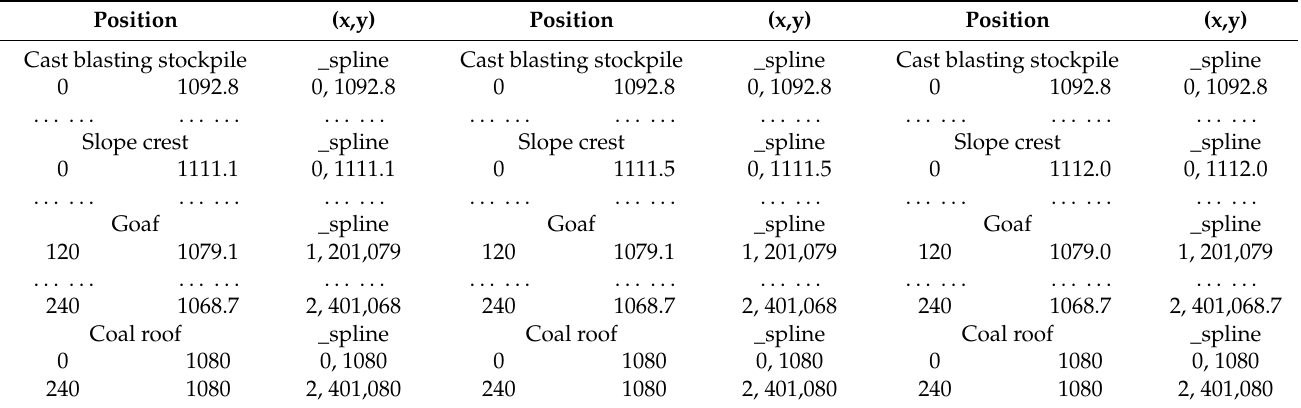
Table 2. Partial point cloud data for cast blasting